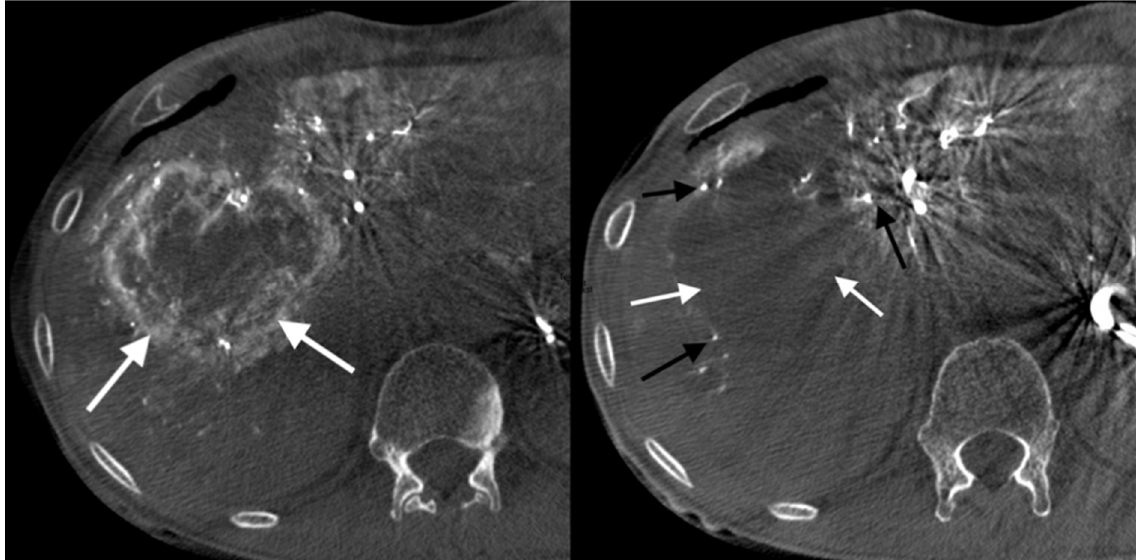
Figure 1. Cone-beam computed tomography image was performed through the SIM catheter in the coeliac artery using 45 mL Iodixanolum (320 mg I/mL) with flow rate of 5 mL/s. Devascularization of a colorectal cancer metastatic liver focal lesion. Left, before the procedure: visible pathological tumor vessels (white arrows). Right, three weeks after the procedure: preserved patency of subsegmental branches (black arrows) and almost complete devascularization of tumor vessels (white arrows).